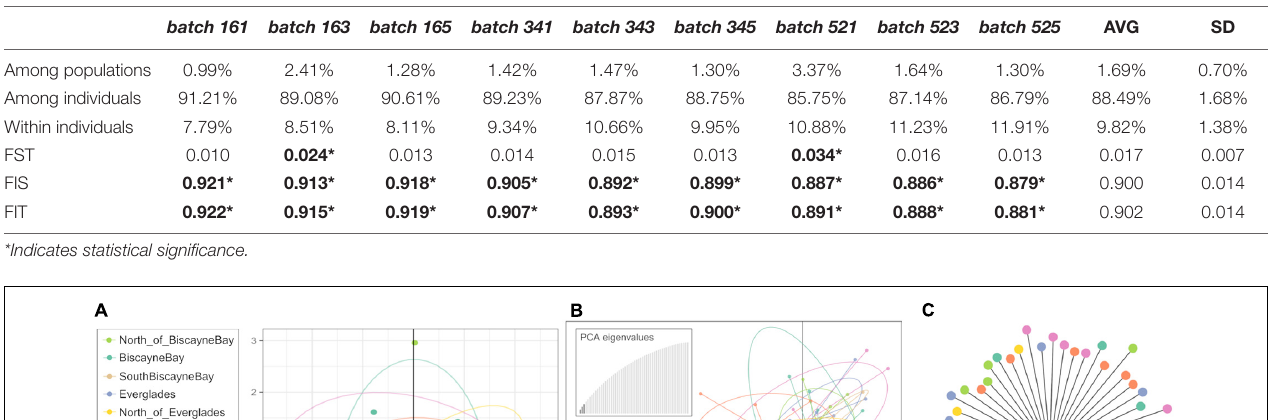
TABLE 3 | Analyses of molecular variance (AMOVA) results and F